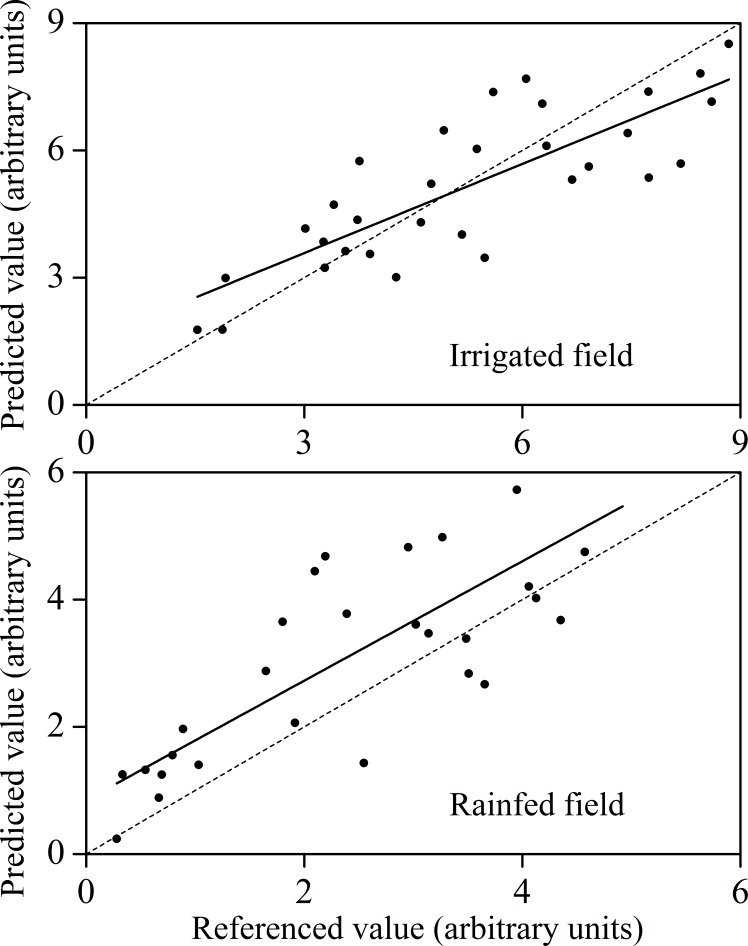
Linear relationships (1:1) between the referenced values and predicted values of LAI in irrigated field and rained field of winter wheat (the solid line and the dotted line are the fitted line and referenced line, respectively).